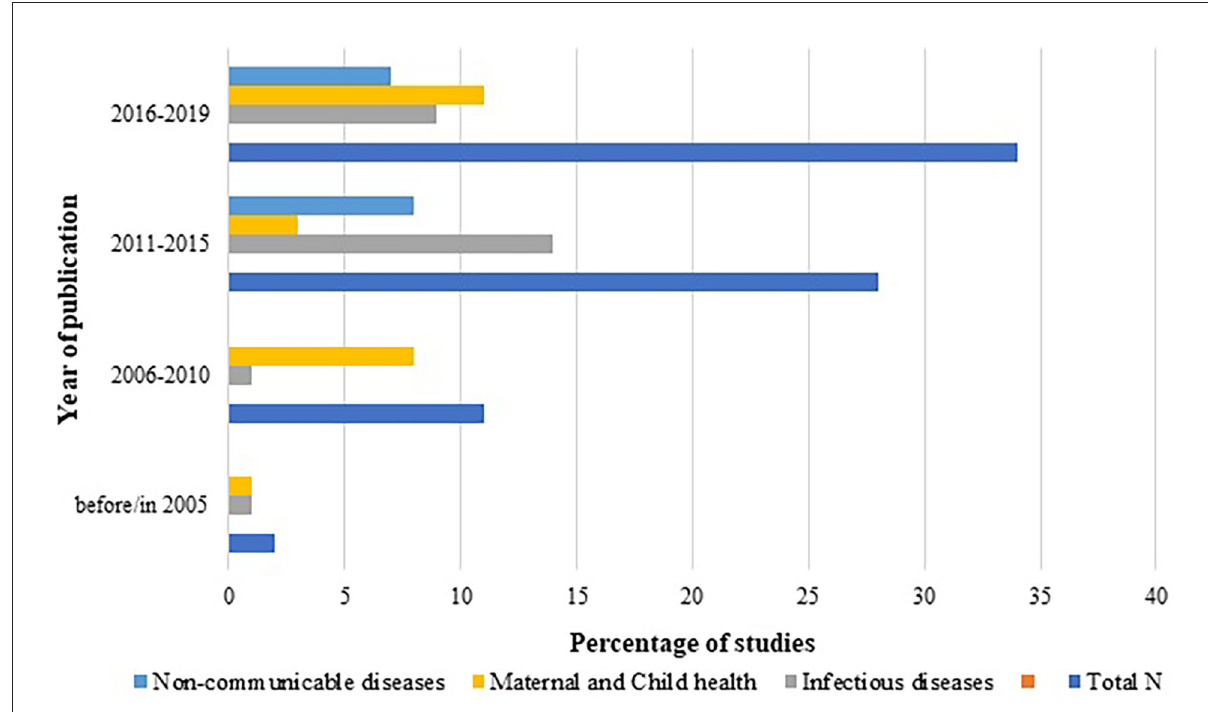
FIGURE5 Number of HTA studies classified as per disease and year of publication.